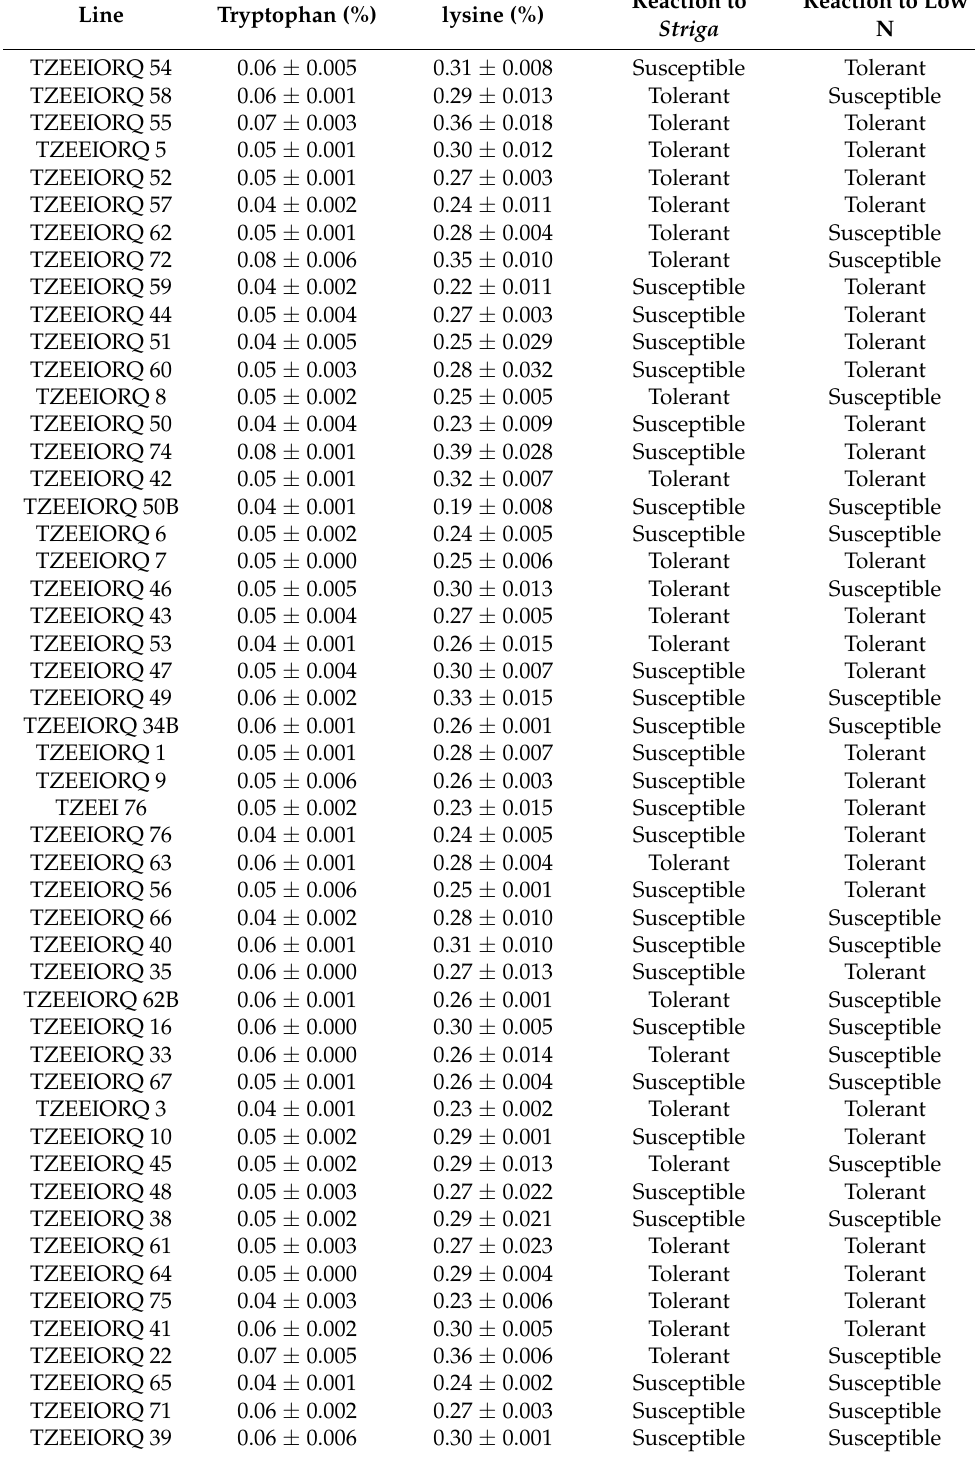
Table 10. Levels of tryptophan and lysine in the extra-early provitamin A quality protein maize inbreds with the most stable check and their responses to Striga and low-N, determined by Striga and low-N base index